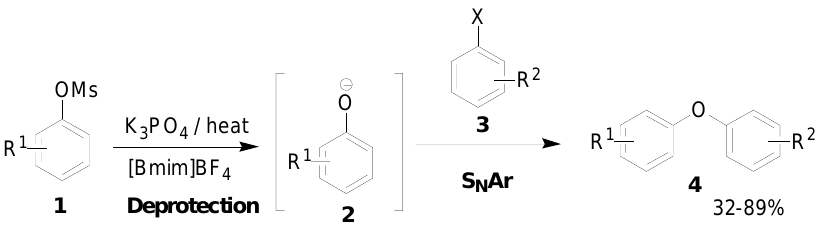
Scheme 1. The route of synthesis of unsymmetrical diaryl